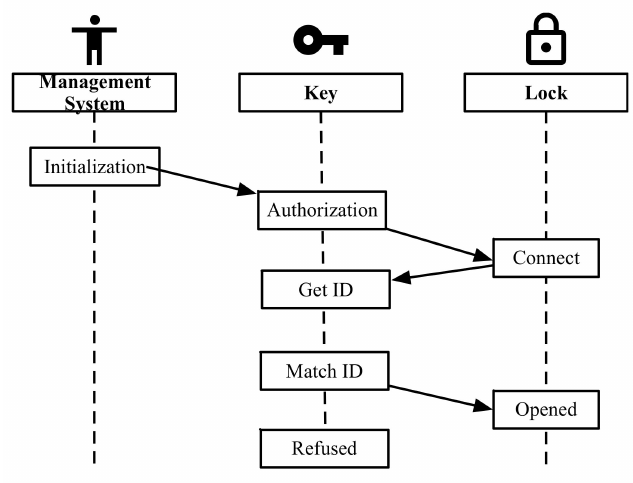
Figure 6. The working flow of RFID lock